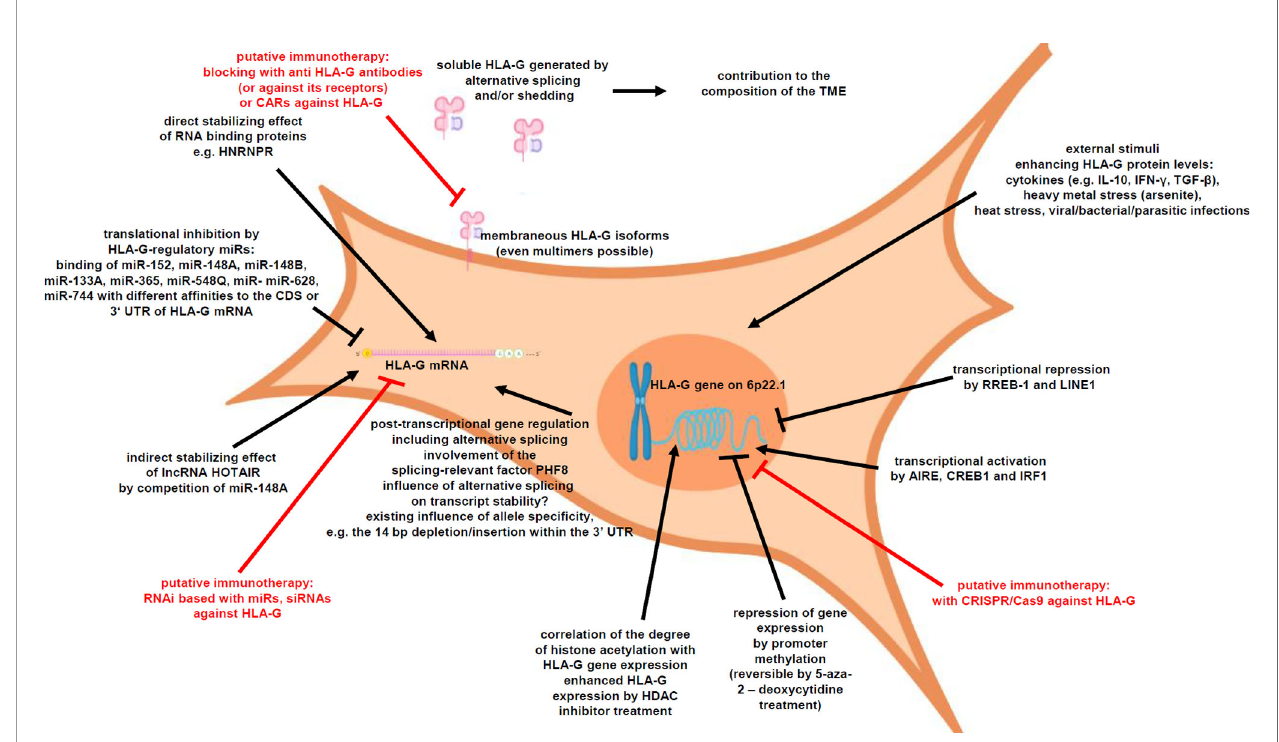
FIGURE 1 | Underlying mechanisms of altered HLA-G